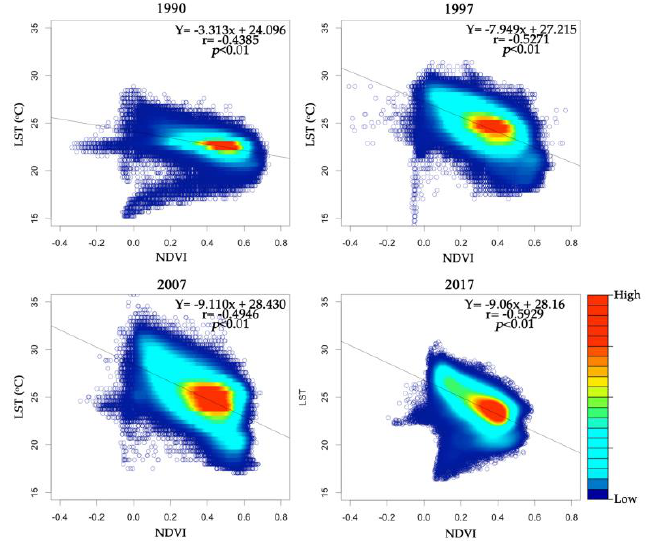
Figure 12. Relation of LST and NDVI .